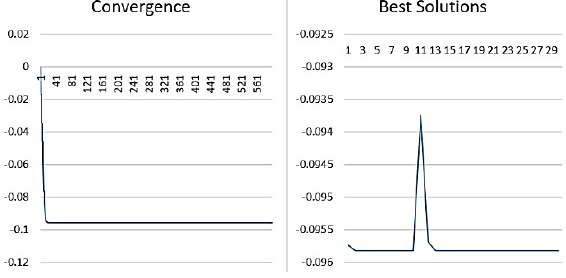
Figure 7. Convergence curve and 30 best solutions for constraint problem